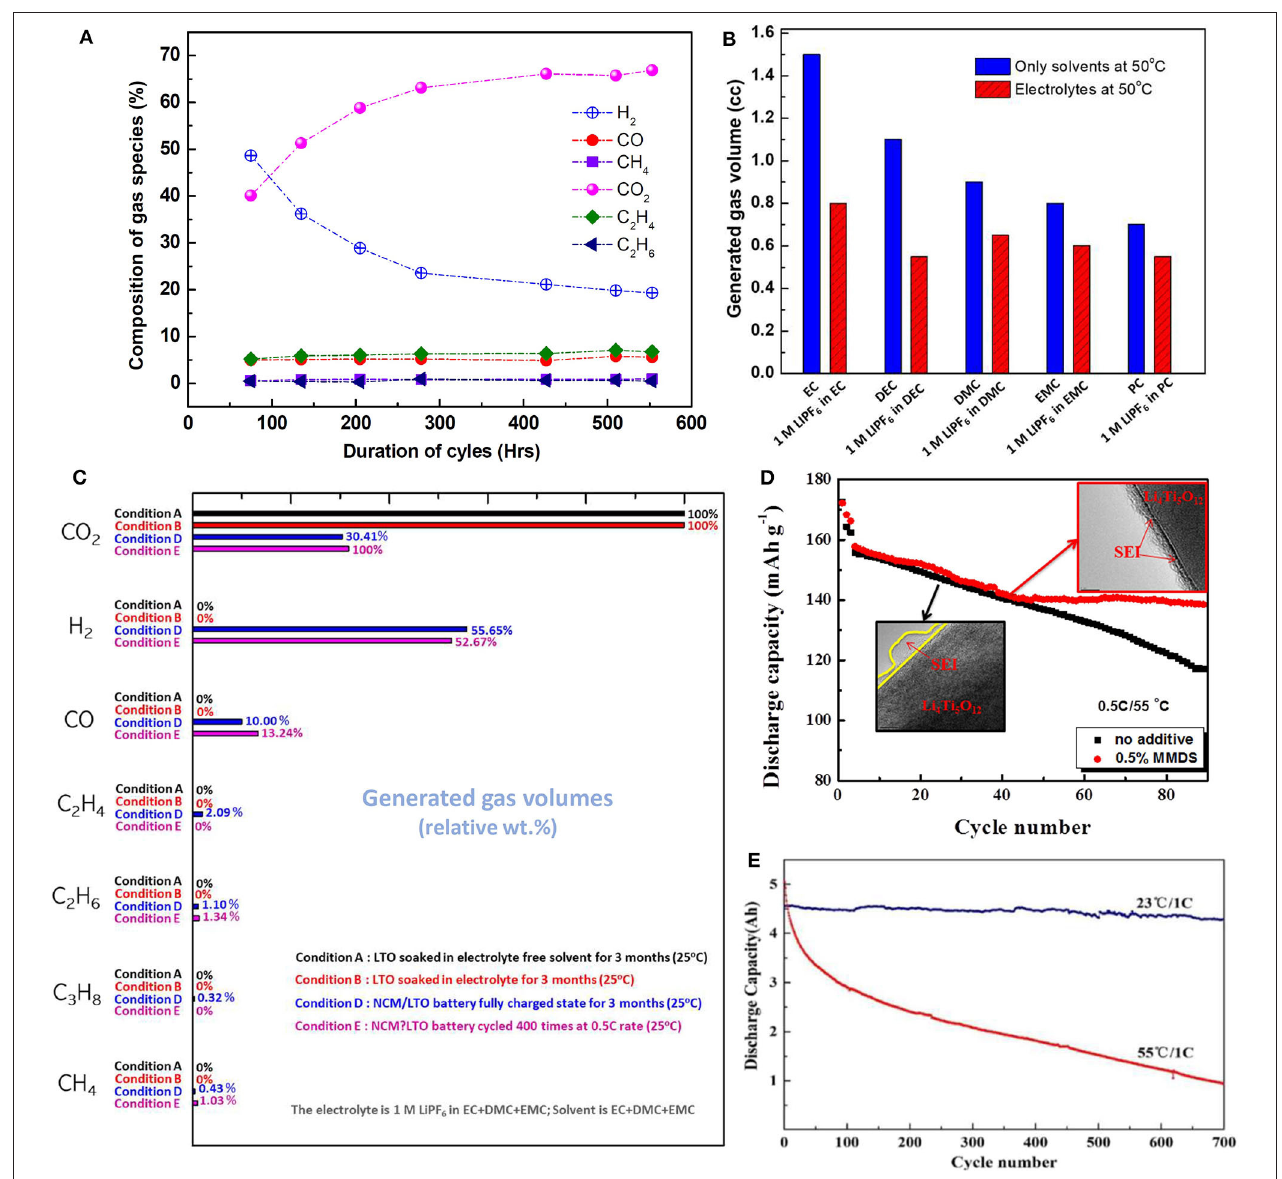
FIGURE 1 | (A) Lithium tantanate (LTO)/nickel manganese cobalt oxide (NMC) pouch cell, the relative amount of the component gases during different stages of the cycled time. (A) is plotted from the data of He et al. (2012a), Wang et al. (2019). (B) Total emitted gas volumes from an NCM/LTO battery when LTO is soaked under conditions with only solvents (blue) and within the electrolytes (red) for 3 months. (C) Relative amount of gas emissions from an NCM/LTO cell under conditions (A,B,D,E) are plotted from the data of He et al. (2012a). (D) Comparison of capacity retentions and associated images of formed solid electrolyte interface (SEI) layers for the two systems; with and without additives. Reproduced from Wang R. et al. (2015). (E) Effect of temperature on cycling of an LTO electrode; samples were cycled at 23 ◦ C and an elevated 55 ◦ C. Reproduced from Wang et al.